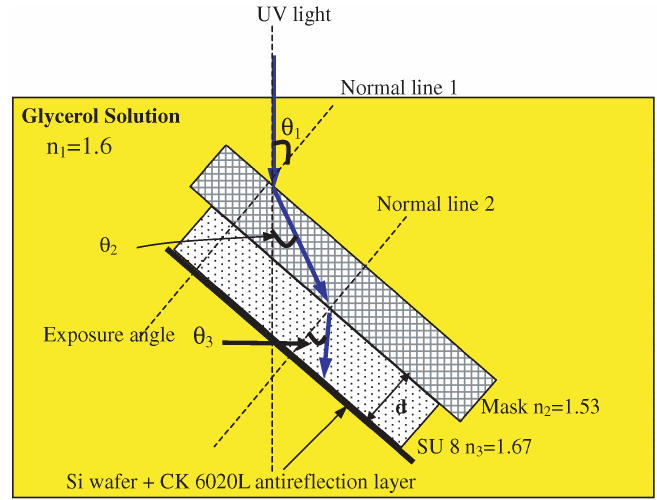
Figure 2. Conceptual schematic diagram of the index-matching glycerol-based immersion UV lithography for high inclined angle SU-8 microstructure fabrication. Reprinted with permission from [20], copyright 2004 Institute of Physics.